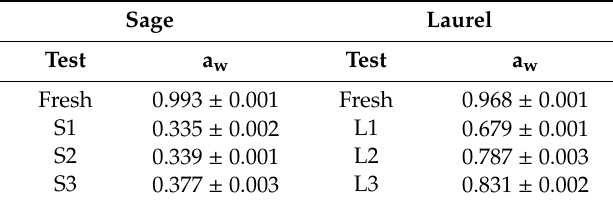
Table 1. Water activity (a w ) values before and after dehydration.